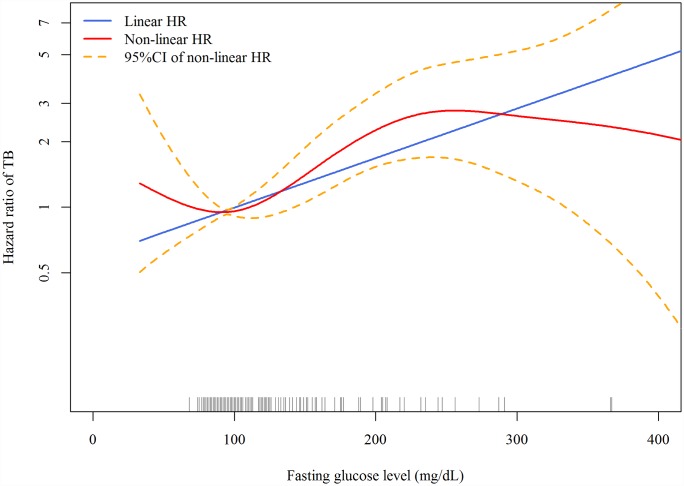
Dose-response curves for fasting plasma glucose and risk of incident tuberculosis in the Cox proportional hazards model.The red line and orange dashed lines represent the point estimates and 95% confidence intervals from the nonlinear analysis using penalized spline regression; the blue line represents the point estimates from the linear analysis. Model adjusted for age, sex, smoking status, alcohol use, betel nut use, education level, marital status, BMI, malignancy, pneumoconiosis, steroid use, ESRD, and frequency of outpatient visits. All variables were adjusted for as categorical variables (see Table 1 for details) except for age, frequency of outpatient visits, and BMI (as continuous variables). HR, hazard ratio.